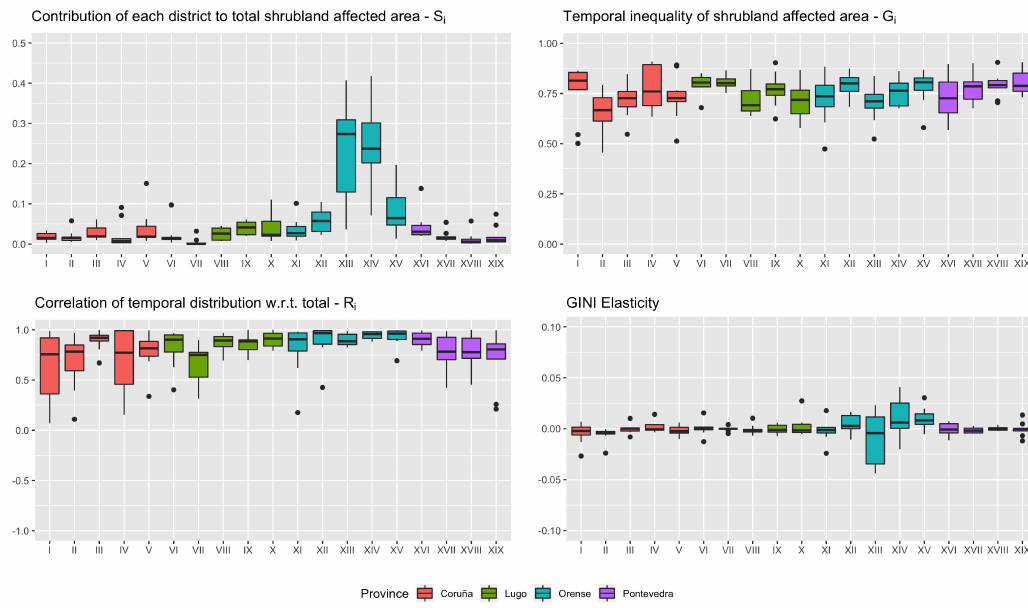
Figure 11. Temporal Gini decomposition of burned shrubland area per forest